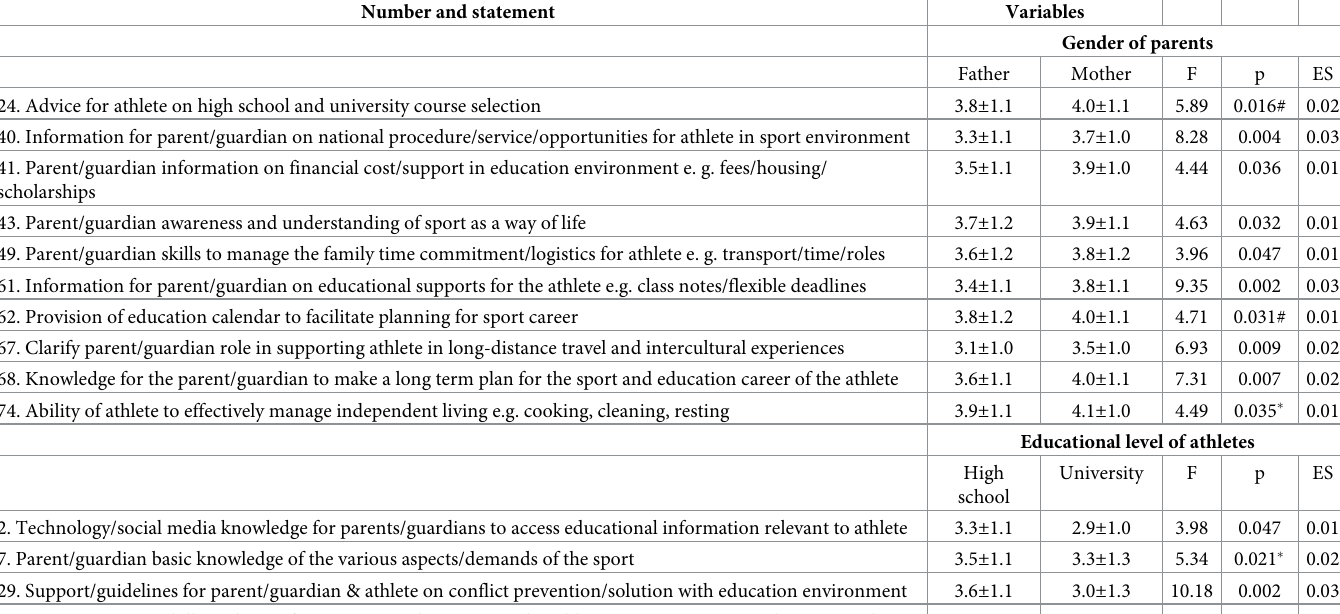
Table 3. Interactions between dependent